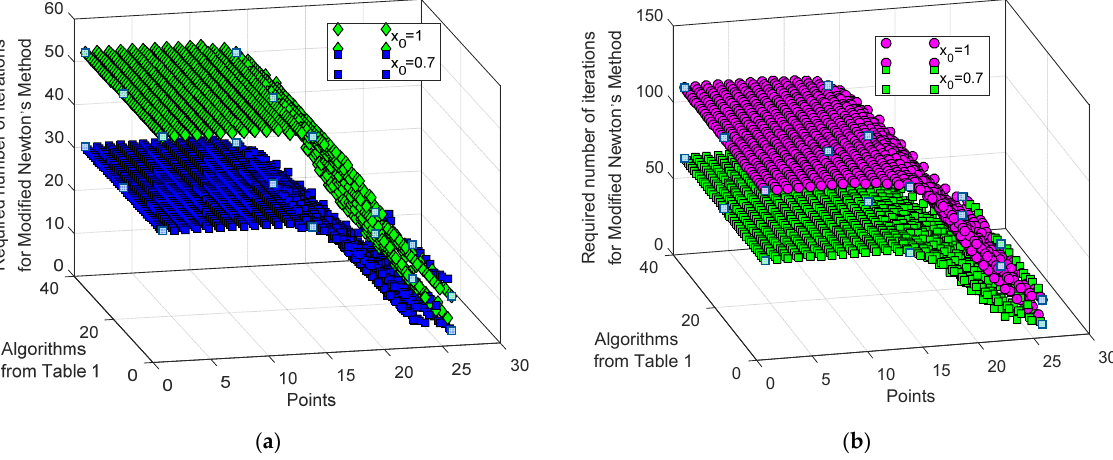
Figure 4. Required number of iterations for all voltage values with different stopping criteria using MNM: ( a ) 10 − 5 ; ( b ) 10 − 10 .